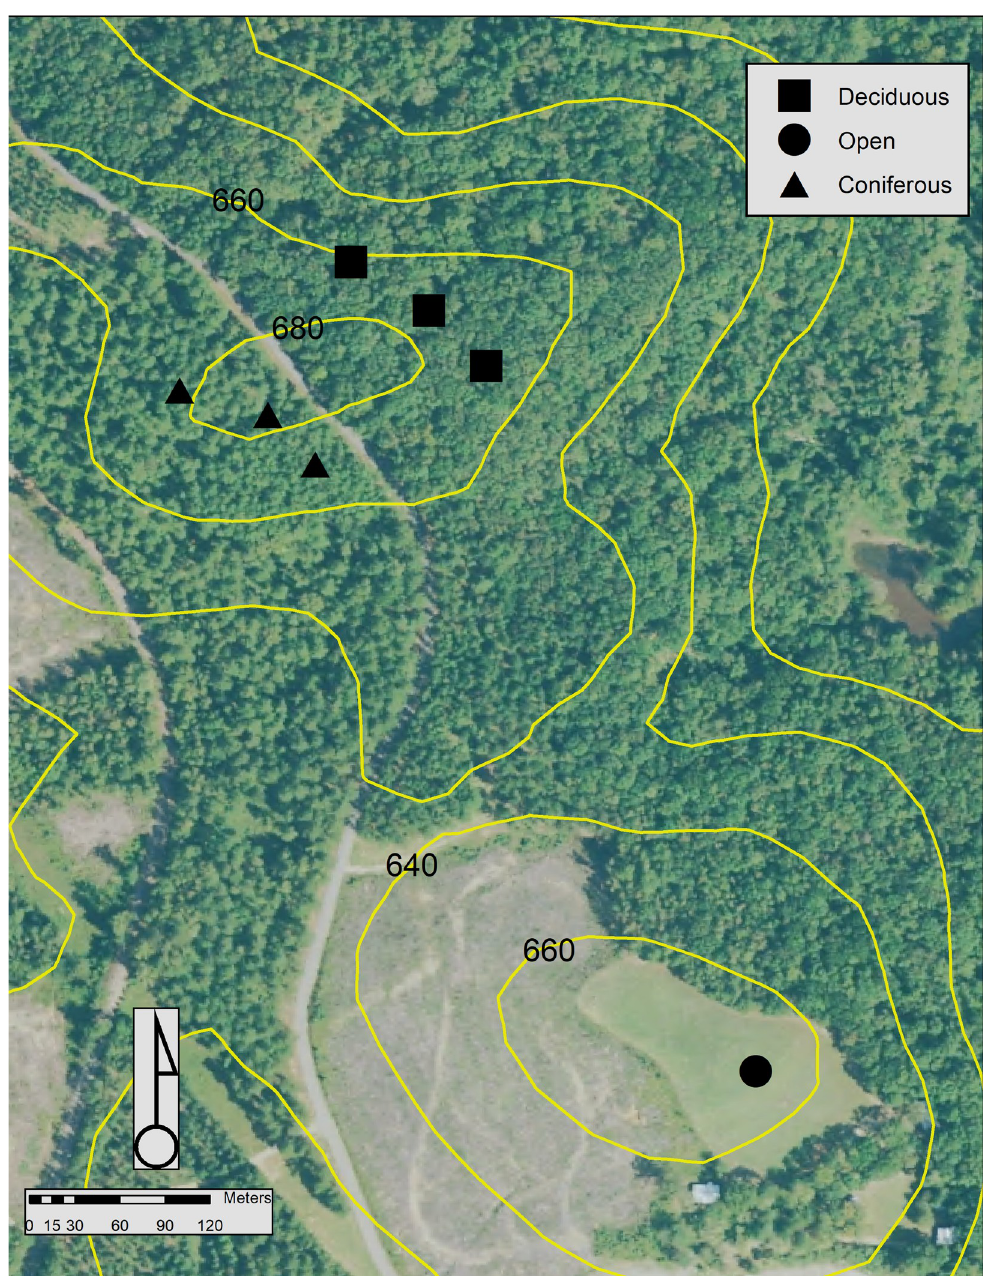
Fig 1. The surveyed area with control points, located at the Whitehall Forest GPS Test Site in Athens, Georgia (USA).